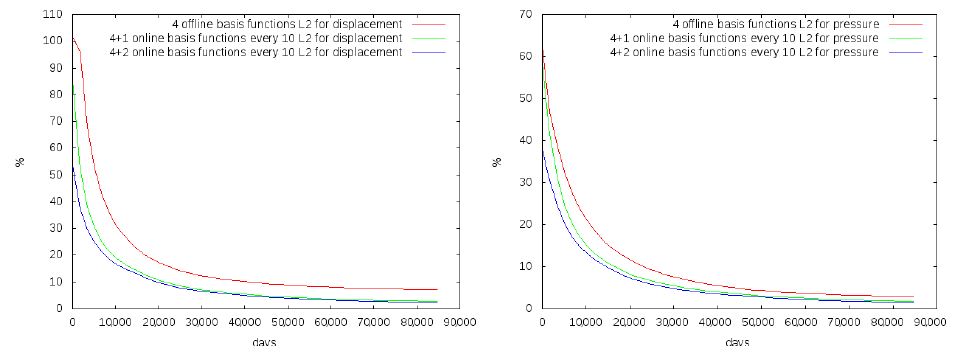
Figure 14. Case 2 . Relative L 2 error vs. time with M of f = 4 for displacements ( left ) and pressure ( right ). M on = 0 (red color), M on = 1 (green), and M on = 2 (blue). Updated at every 10 time